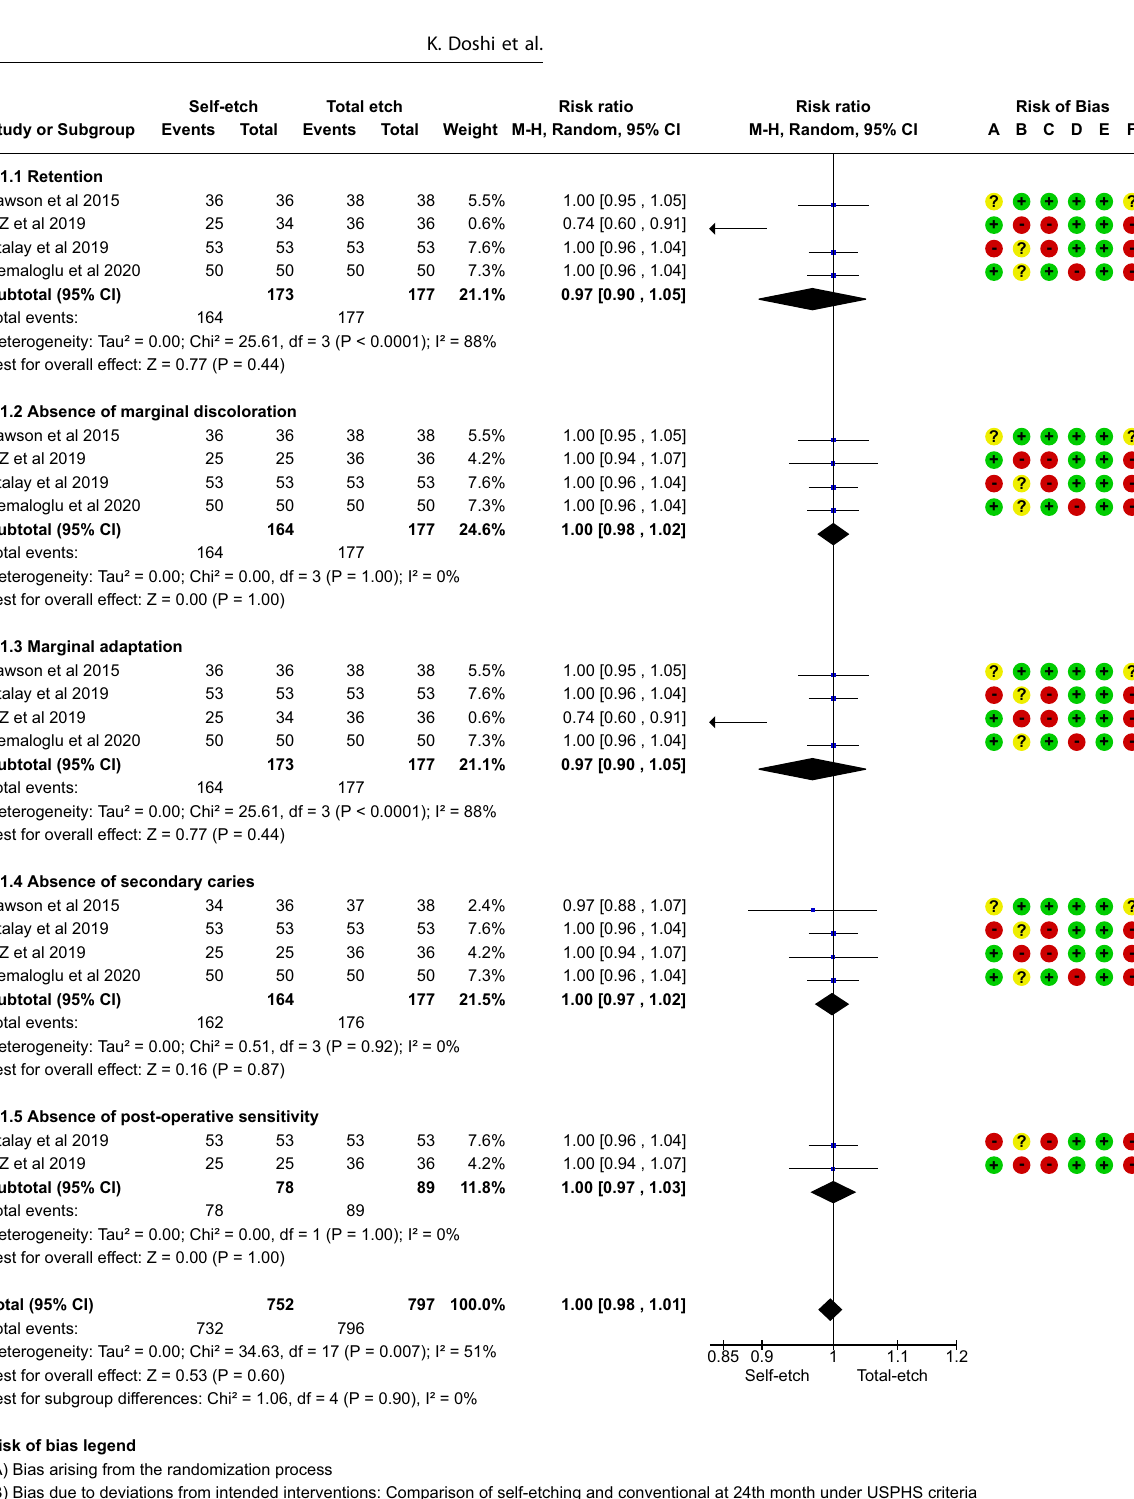
(B) Bias due to deviations from intended interventions: Comparison of self-etching and conventional at 24th month under USPHS criteria (C) Bias due to missing outcome data: Comparison of self-etching and conventional at 24th month under USPHS criteria (D) Bias in measurement of the outcome: Comparison of self-etching and conventional at 24th month under USPHS criteria (E) Bias in selection of the reported result: Comparison of self-etching and conventional at 24th month under USPHS criteria (F) Overall bias: Comparison of self-etching and conventional at 24th month under USPHS criteria Fig. 8 Forest plot representing the pooled events at 24 months using USPHS criteria. No signi fi cant difference observed between total etch and self-etch adhesive strategies for any of the